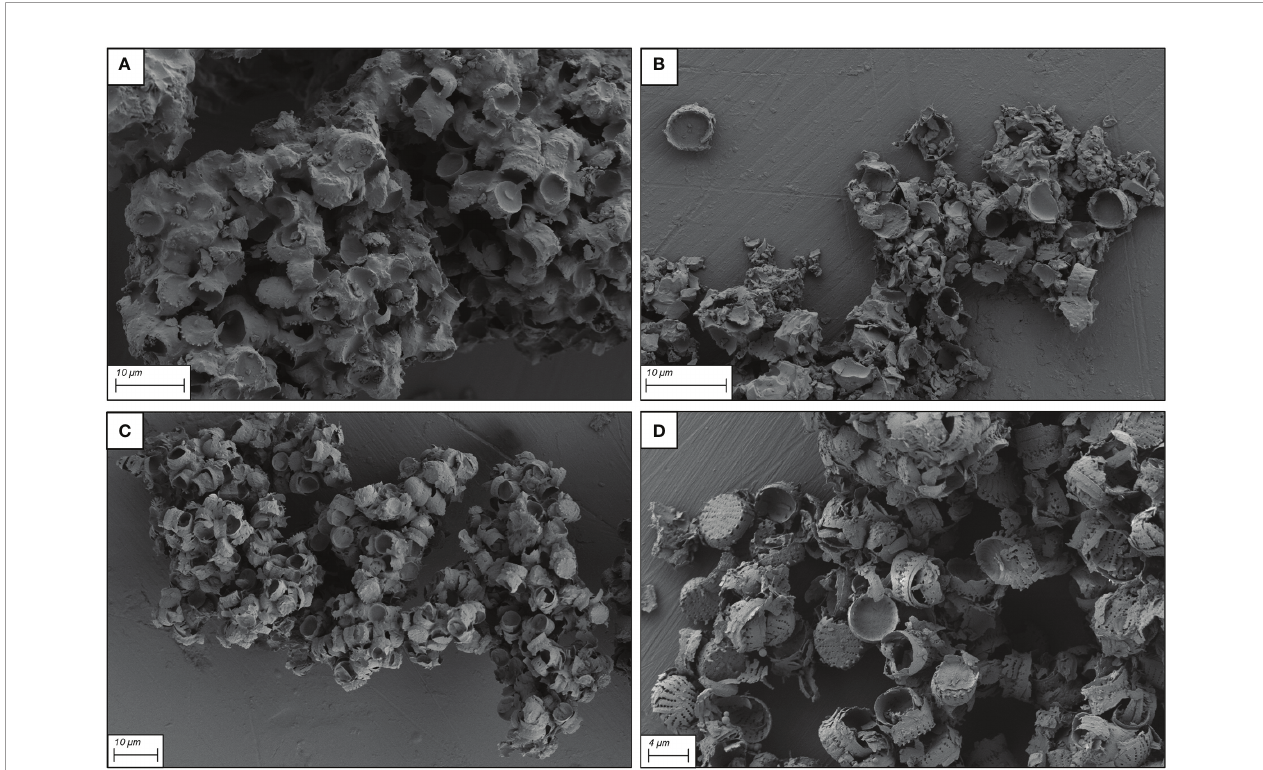
FIGURE 3 | SEM micrographs of functionalized frustules after 9 h functionalization with different concentrations of the hydroxylation reagent NH 4 OH. (A) 30 mM, (B) 20 mM, (C) : 10 mM and (D) : 5